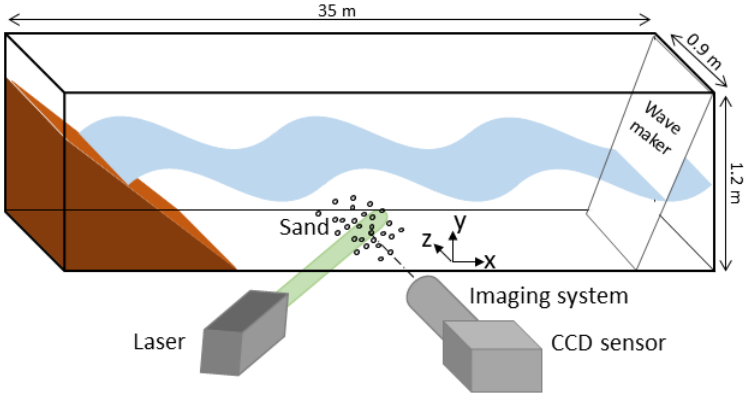
Figure 2. General experimental set-up.